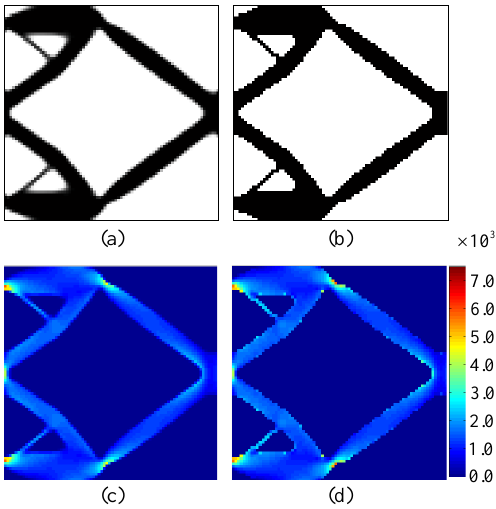
Figure 6. (a) Optimal configuration density distribution; (b) Von Mises stress distribution of (a) ; (b) Configuration after removing grayscale areas; (d) Von Mises stress distribution of (b)